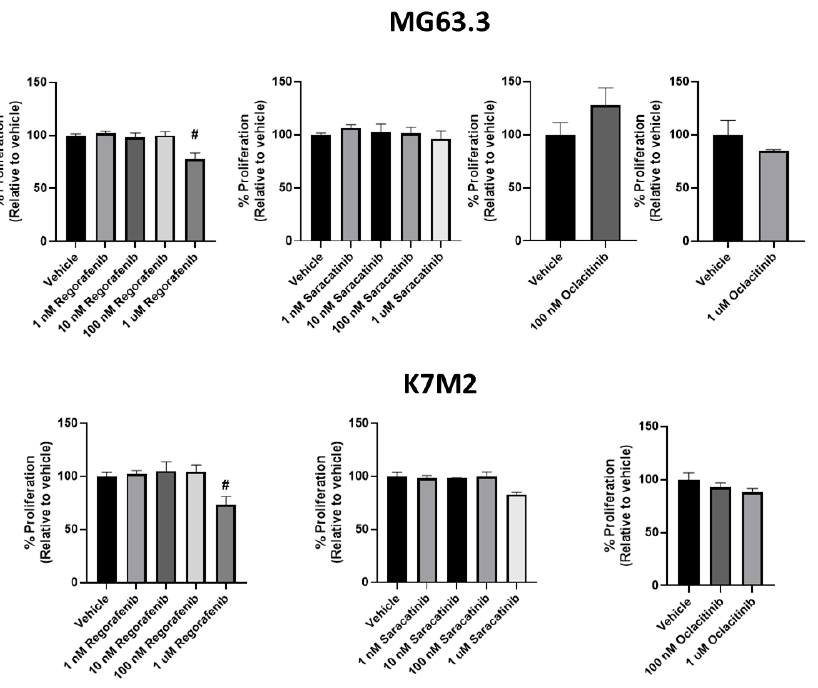
Figure 3. The activity of antimetastatic drugs in the 3D BME system on day 6. Using the 3D BME system, highly metastatic osteosarcoma cells were treated with regorafenib, saracatinib, and oclacitinib at varying doses (1 nM −1 μM) and the % proliferation at day 6 was determined by MTS assay. MG63.3 and K7M2 cells were treated with the inhibitors and only regorafenib was found to significantly inhibit the proliferation (relative to vehicle [0.1% DMSO] control) (>20%, # p < 0.005) across both cell lines at a dose (1 μM) that is not cytotoxic in 2D culture (See Figure 2).